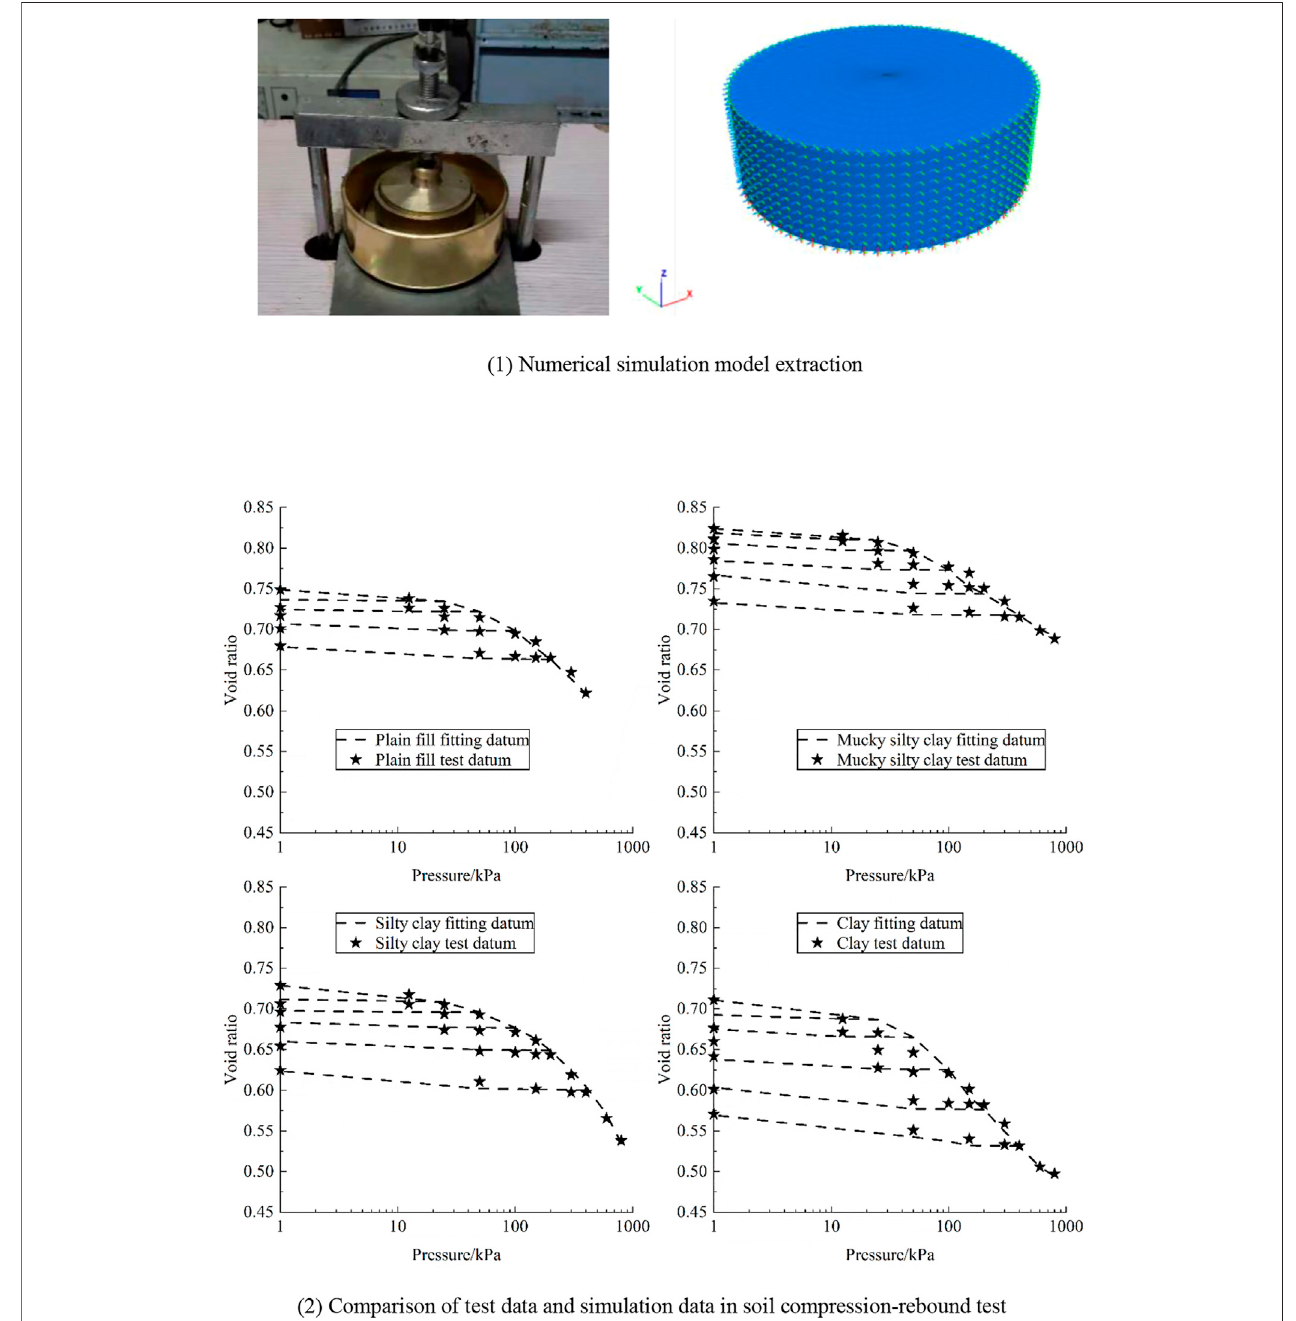
FIGURE 4 | Numerical simulation model extraction and comparison of test data and simulation